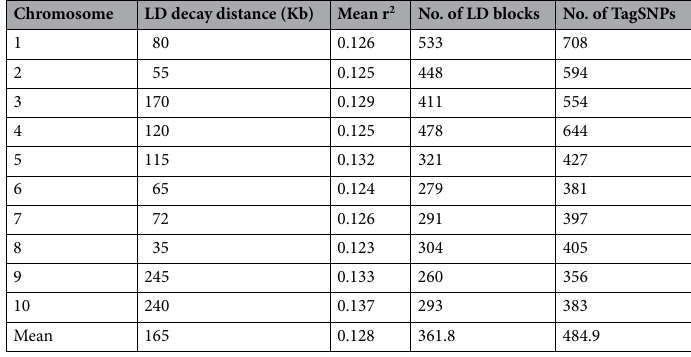
LD decay distance (Kb) Mean r 2 No. of LD blocks No. of